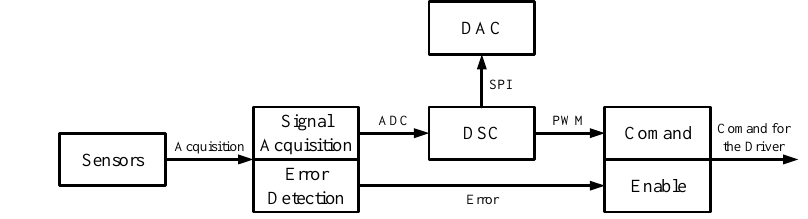
Figure 19. Block diagram of the control system.